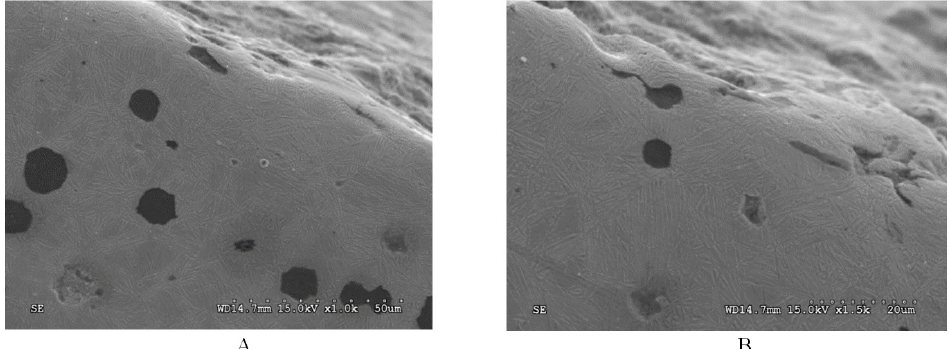
Figure 8. Deformations of graphite in the wheel made of ADI_360_D. ( A ) Graphite deformed as a result of the direct action of the abrasive at the point of contact between the socket and the chain. ( B ) Graphite with elongated and curved end deformation (SEM; cross-section).